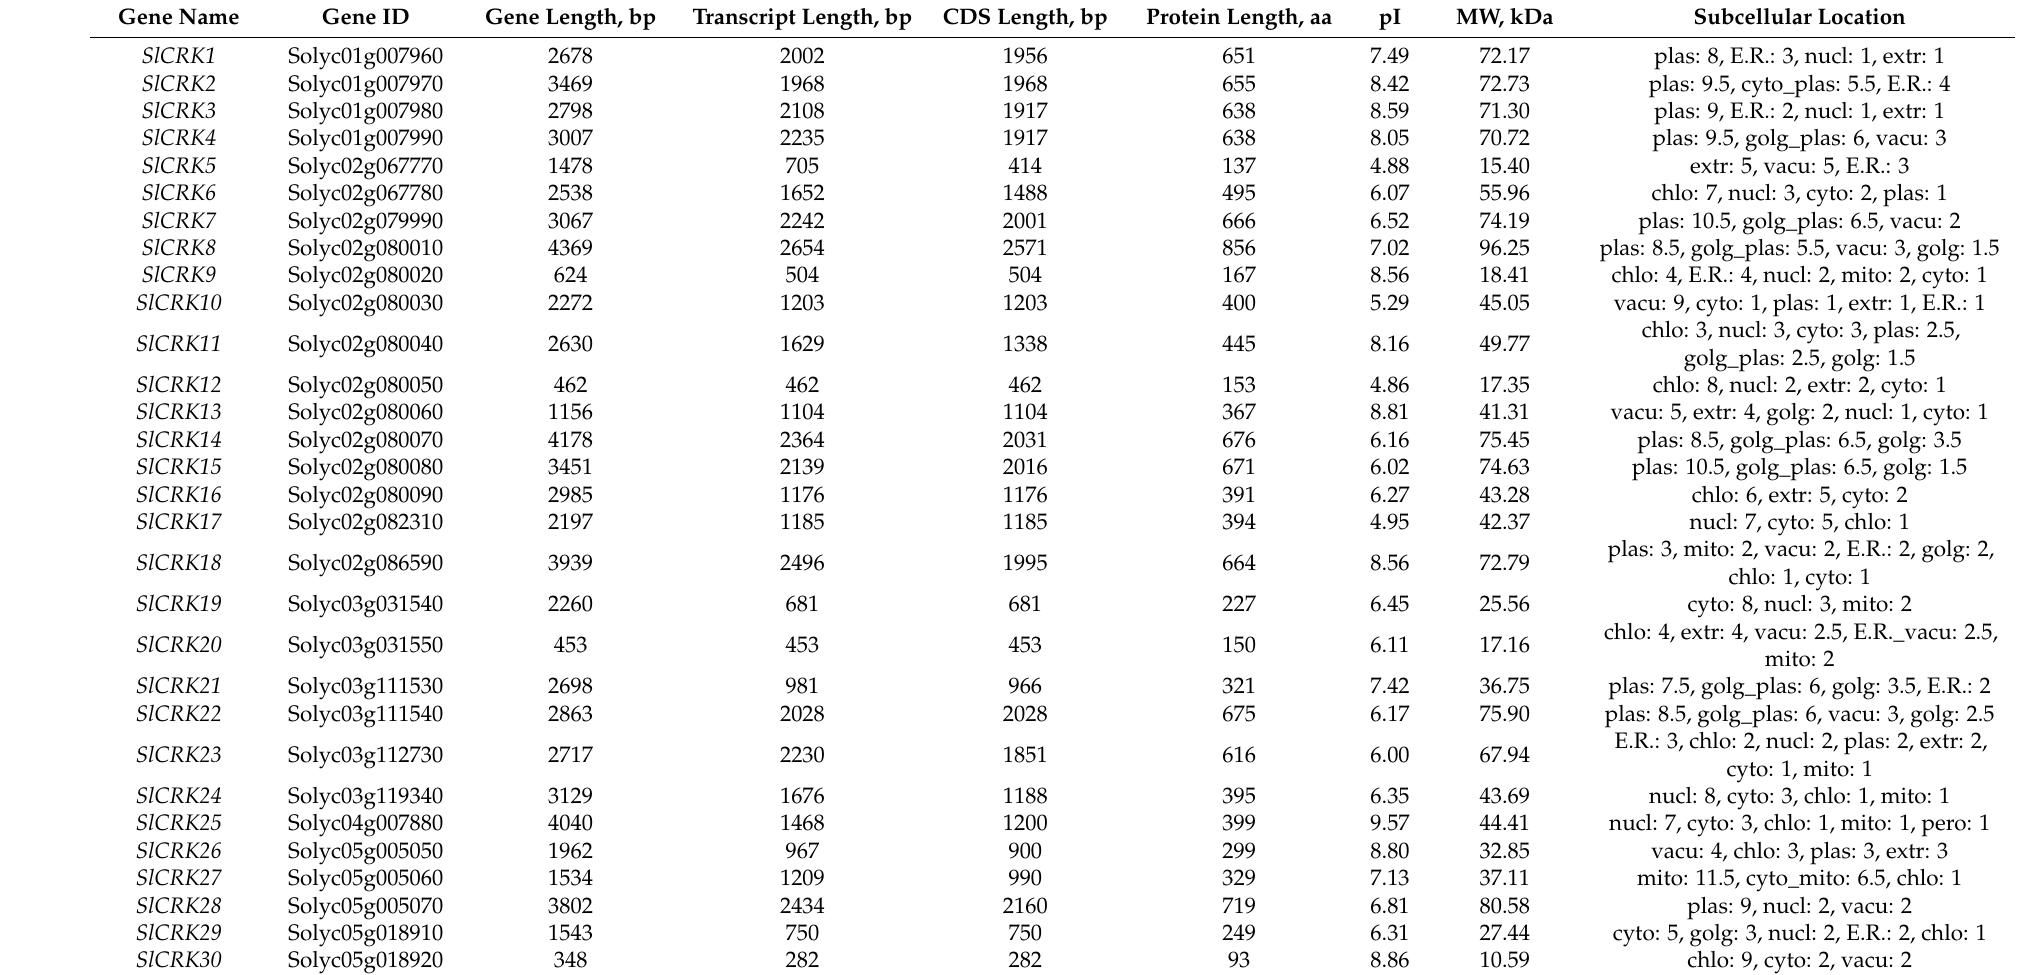
Table 1. SlCRK gene family members in Solanum lycopersicum.